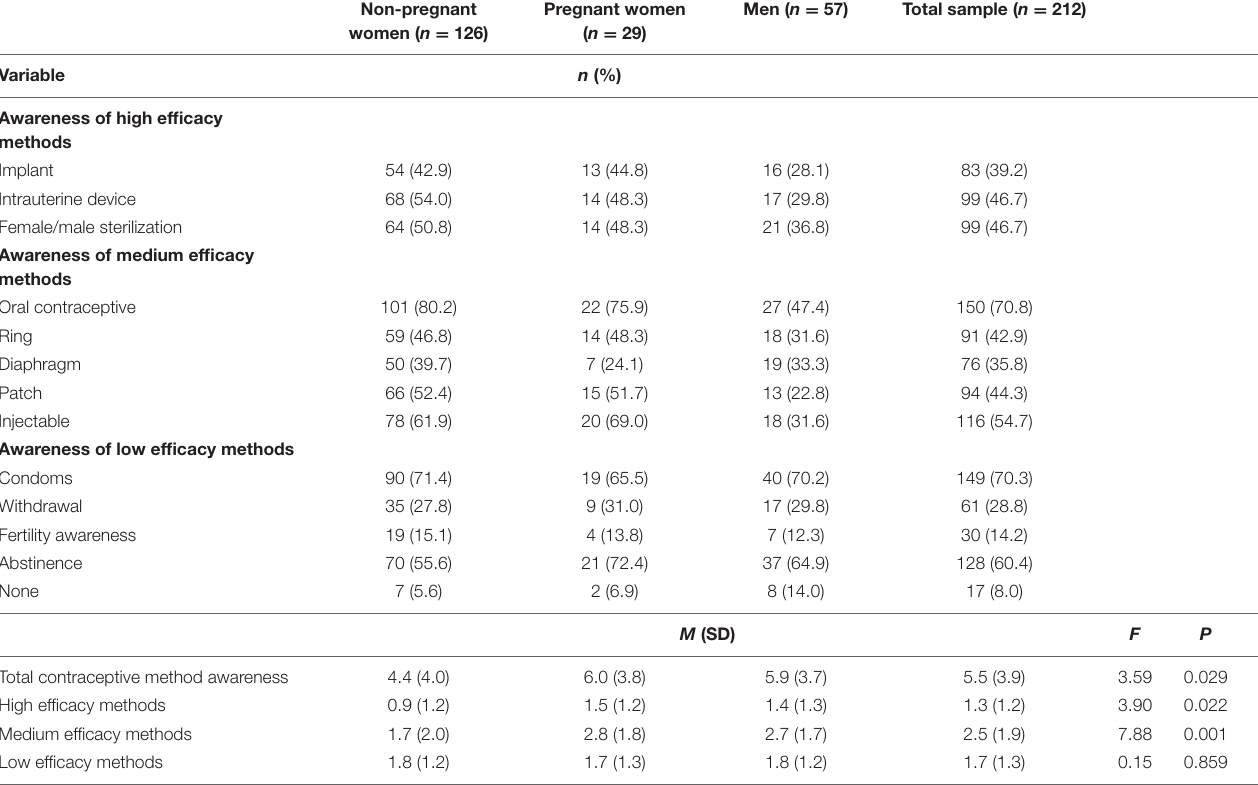
TABLE 3 | Contraceptive method awareness from a health professional.